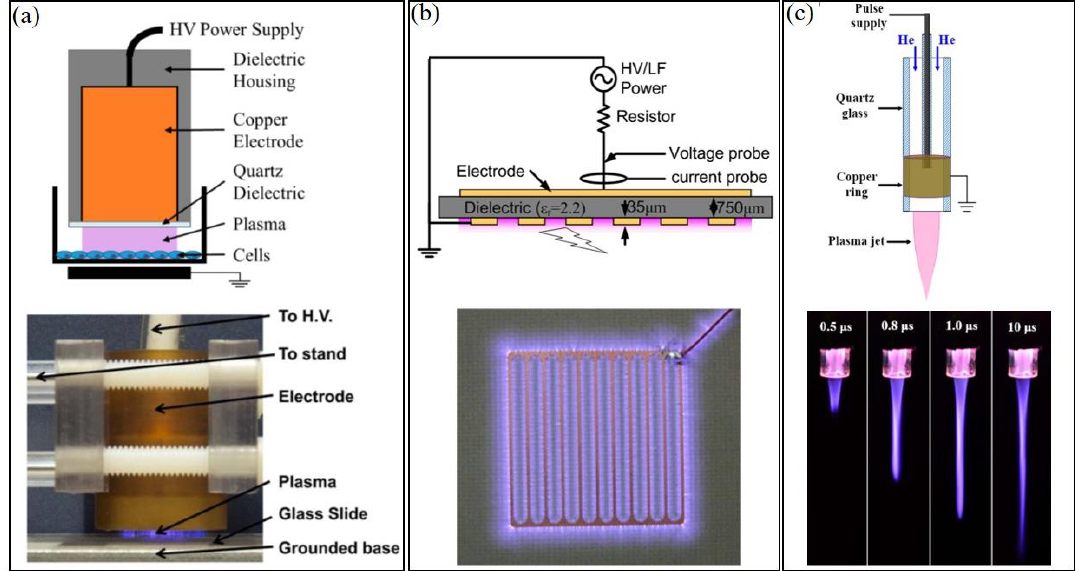
Figure 1. Typical CAP sources. ( a ) A volume DBD source [16,17]. ( b ) A surface DBD source [18]. ( c ) A CAP jet source. The length of plasma jet can be modulated by controlling signals, such as pulse width (µs) [14].